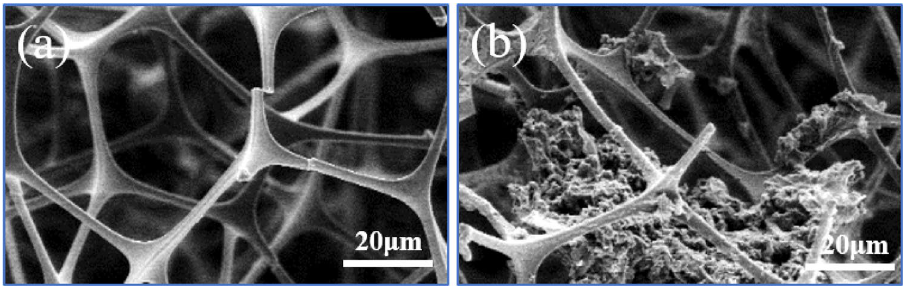
Figure 13. SEM images of OTS-PDA-MS for different dosages of OTS. ( a ) 0.1 ml of OTS; ( b ) 2 ml of OTS.